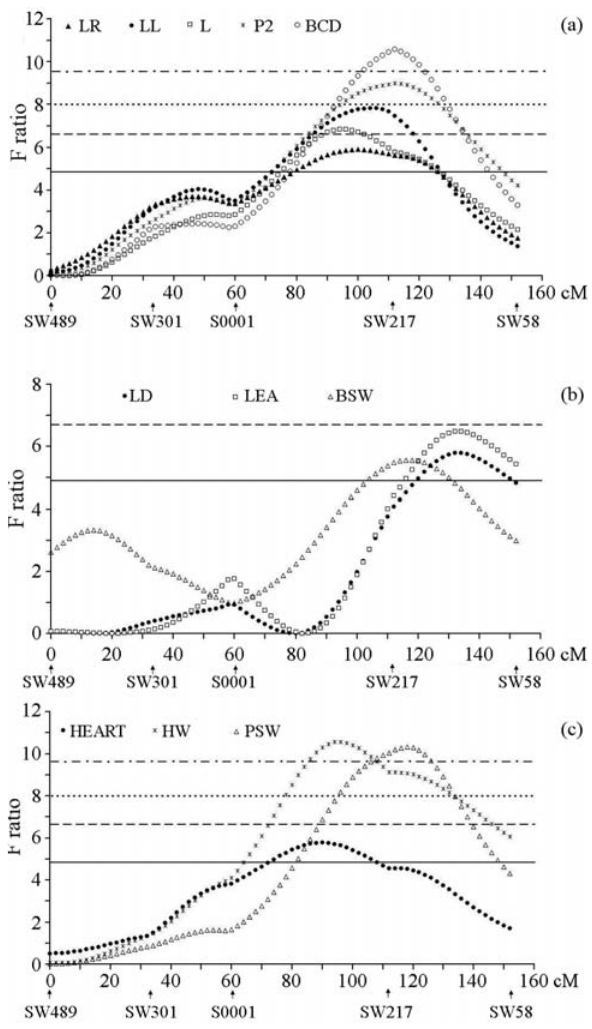
Figure 1 - (a) F ratio estimates for fat thickness: bacon depth (BCD), backfat thickness at 6.5 cm from the midline (P2), lower backfat thickness after last lumbar vertebrae (L), midline backfat thickness after last rib (LR), backfat thickness between last 1st-2nd lumbar vertebrae (LL). The horizontal lines indicate the levels of significance: chromosome-wide (5% = continuous line, 1% = dashed line) and genome-wide (5% = dotted line, 1% = dot-dashed line). (b) F ratio estimates for loin depth (LD), loin eye area (LEA), and skinless and fatless boston shoulder weight (BSW). The horizontal lines indicate the chromosome-wide (5% = continuous line, 1% = dashed line) levels of significance. (c) F ratio estimates for skinless and fatless ham weight (HW), skinless and fatless picnic shoulder weight (PSW), and heart weight (HEART). The horizontal lines indicate the lev- els of significance: chromosome-wide (5% = continuous line, 1% = dashed line) and genome-wide (5% = dotted line, 1% = dot-dashed